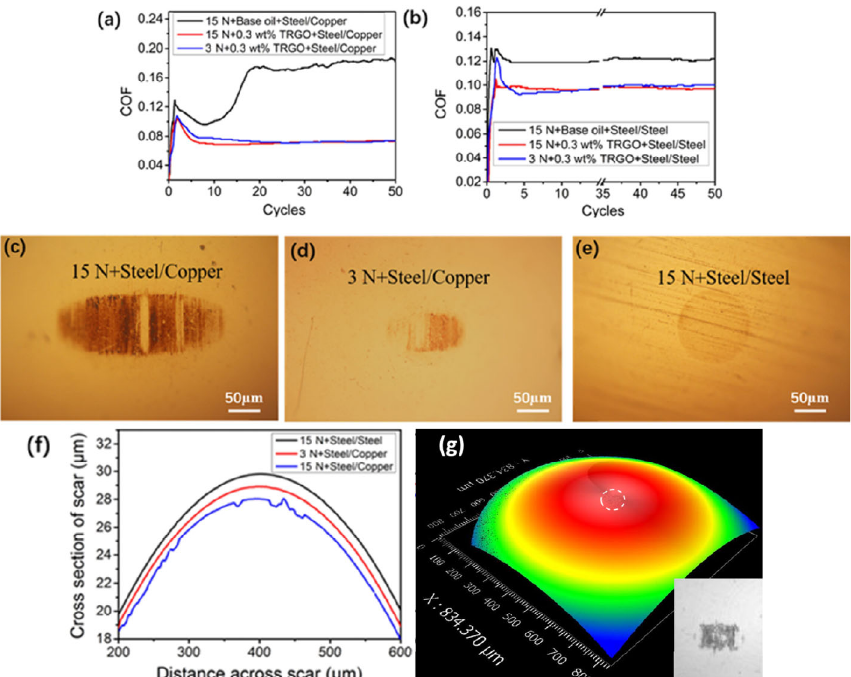
Fig. 5 COFs and wear scar of steel/copper and steel/steel friction pairs. (a) and (b) The COFs of TRGO in the first 100 seconds of rubbing tests; (c) – (e) the wear scars of the upper samples of steel balls after 25 seconds of rubbing tests under 15 N or 3 N measured by an optical microscope; (f) the cross section of wear scars in (c) – (e) in the horizontal direction; (g) the 3D image of the steel ball against copper disk lubricated by TRGO under 15 N for 30 min. The inset is the corresponding optical microscope image of the ball